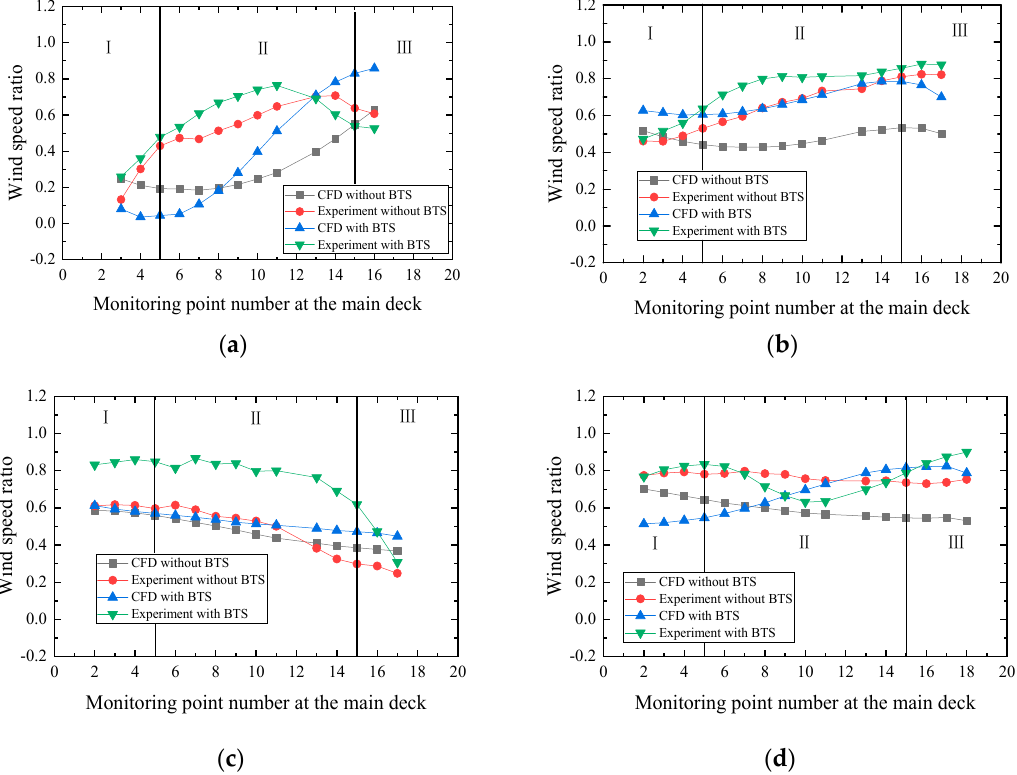
Figure 13. Non-dimensional cross-bridge wind speed at main deck level under different cases. ( a ) Case 1; ( b ) Case 2; ( c ) Case 3; ( d ) Case 4.